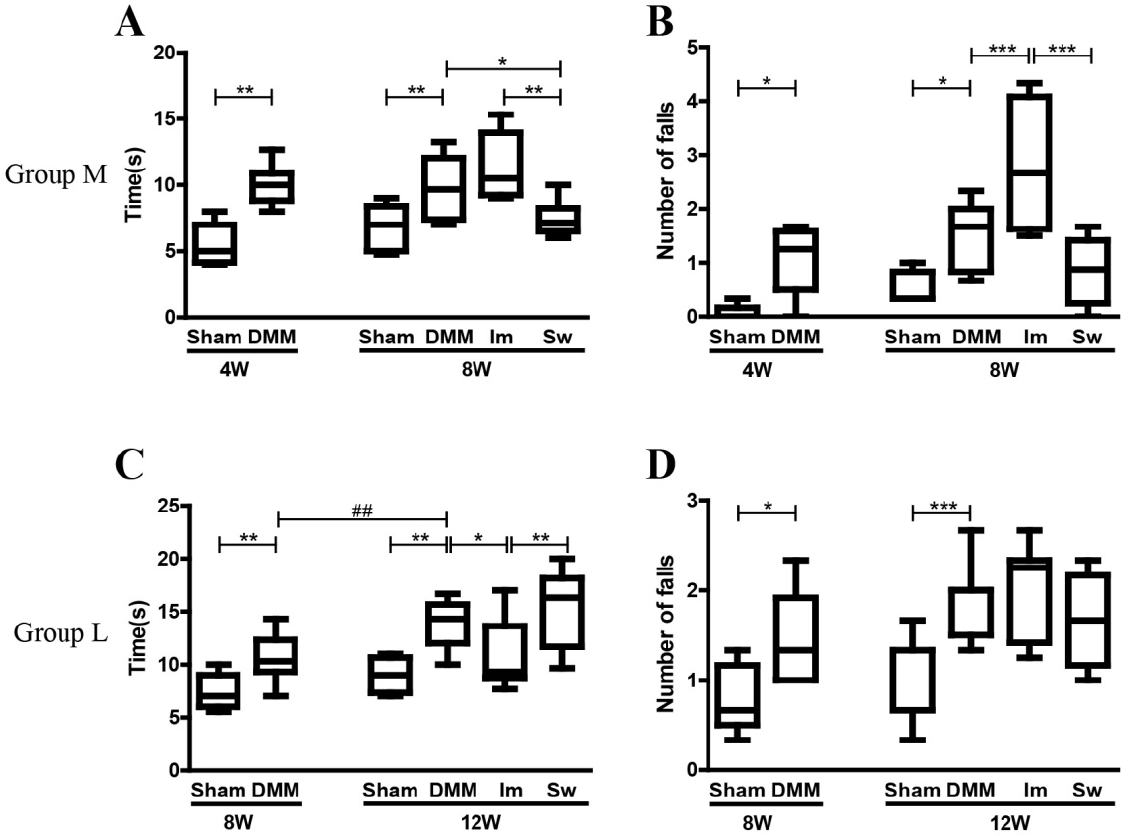
Figure 3. Beam walking test showing that immobilization aggravated the disadvantages of DMM on the balance ability at the middle stage of OA. ( A ) DMM significantly increased the time to cross the beam and ( B ) the number of times the mice fell off the beam, and immobilization further aggravated the imbalance, whereas swimming reduced the time at the middle stage of OA. ( C ) Immobilization reduced the time to cross the beam ( D ) but not the number of times the mice fell off the beam, whereas swimming had no effects at the late stage of OA. Group M: middle stage of OA, 4 weeks after DMM and Group L: late stage of OA, 8 weeks after DMM. 4W: the time point of starting swimming or immobilization, which is 4 weeks after DMM surgery. 8W ( A , B ): the time point after 4 weeks of swimming and immobilization, which is 8 weeks after DMM surgery. 8W ( C , D ): the time point of starting swimming or immobilization, which is 8 weeks after DMM surgery. 12W: the time point after 4 weeks of swimming and immobilization, which is 12 weeks after DMM surgery. Im, immobilization; Sw, swim; DMM, destabilization of the medial meniscus; * p < 0.05, ** p < 0.01, *** p < 0.001, ## p <0.01 (difference between 8 W and 12W after DMM), n ≥ 6.